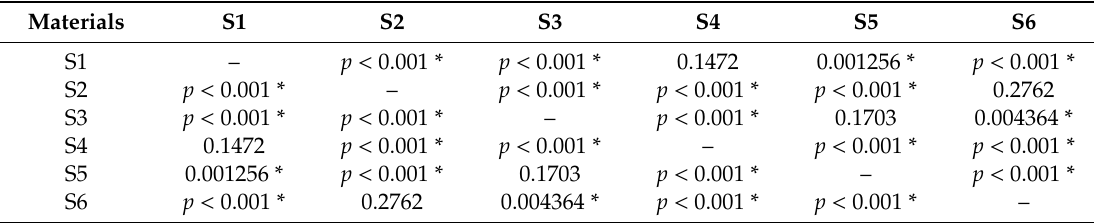
Table 3. Di ff erences in ∆ E after 168 h immersion in water.